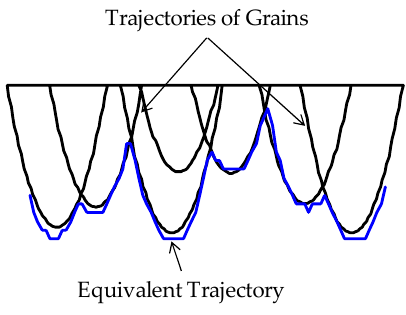
Figure 6. Ground surface generated by the resultant of multiple trajectories.